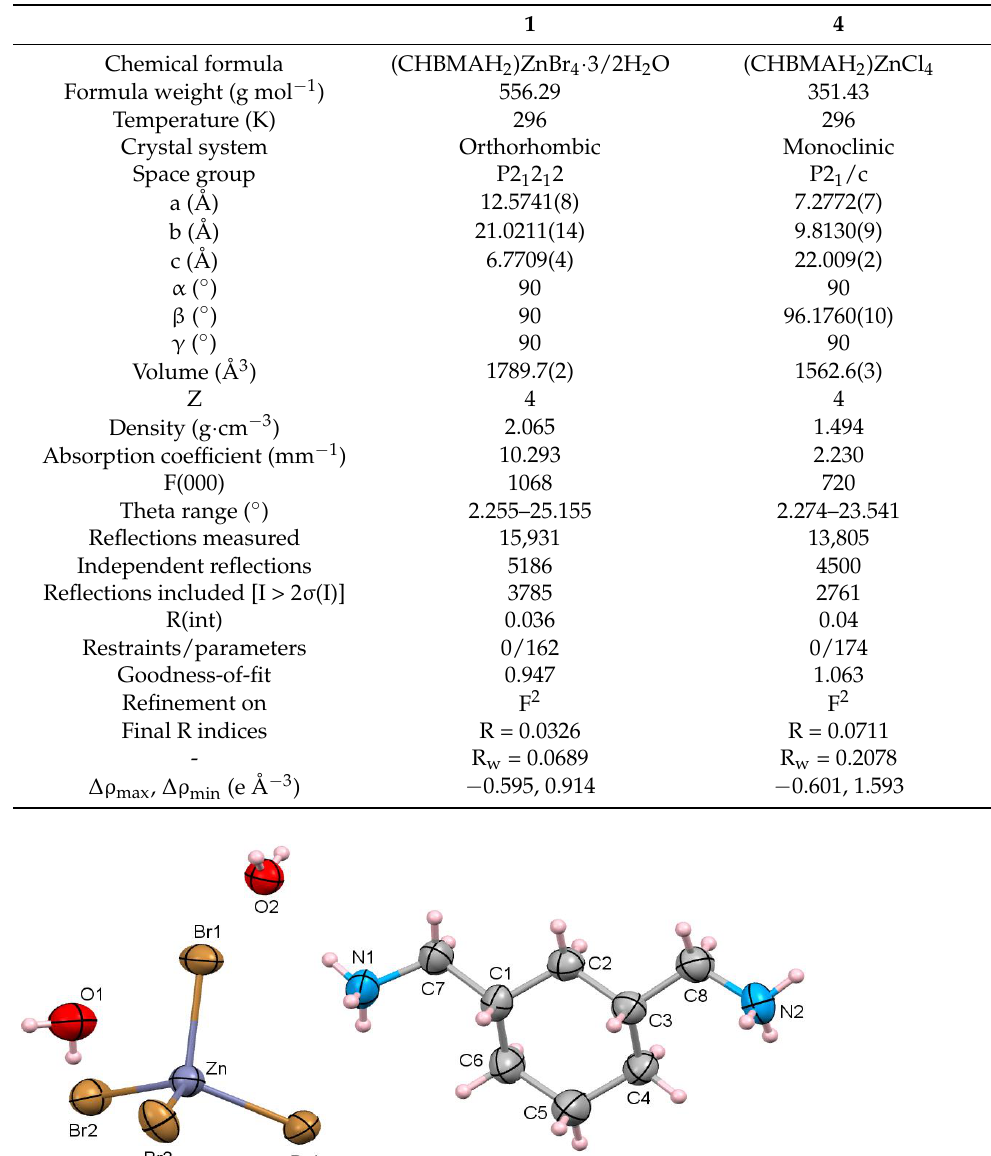
Table 1. Crystallographic data and structural refinement parameters for compounds 1 and 4 .